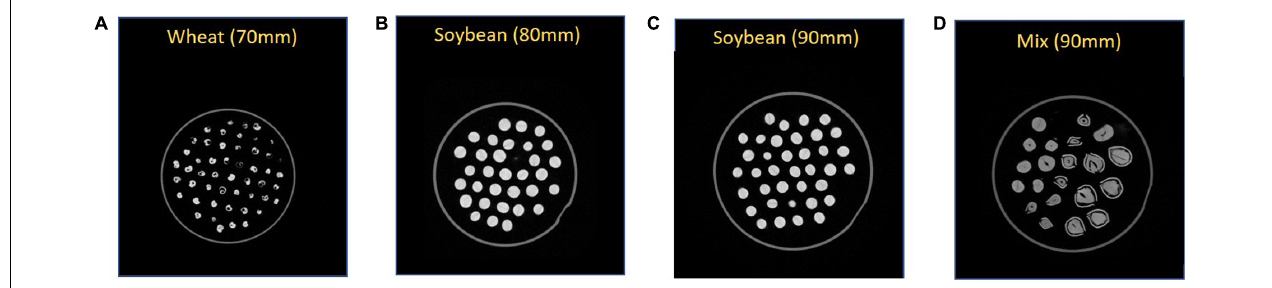
FIGURE 3 | The raw X-ray computed tomography images. (A) wheat seeds in the container with a diameter of 70 mm; (B) soybean seeds in the container with a diameter of 80 mm; (C) soybean seeds in the container with a diameter of 90 mm; (D) peanuts, pine nuts, and pistachio nuts in the container with a diameter of 90